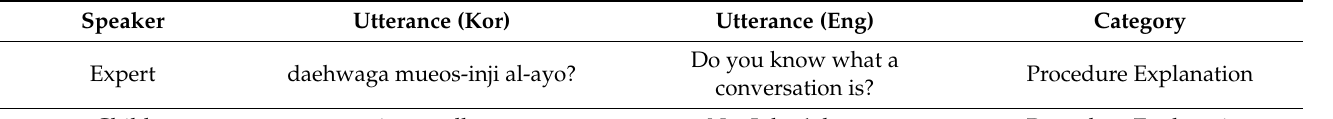
Table 1. Transcribed examples of data collected by the conversation collection protocol. The same utterance is expressed in Korean and